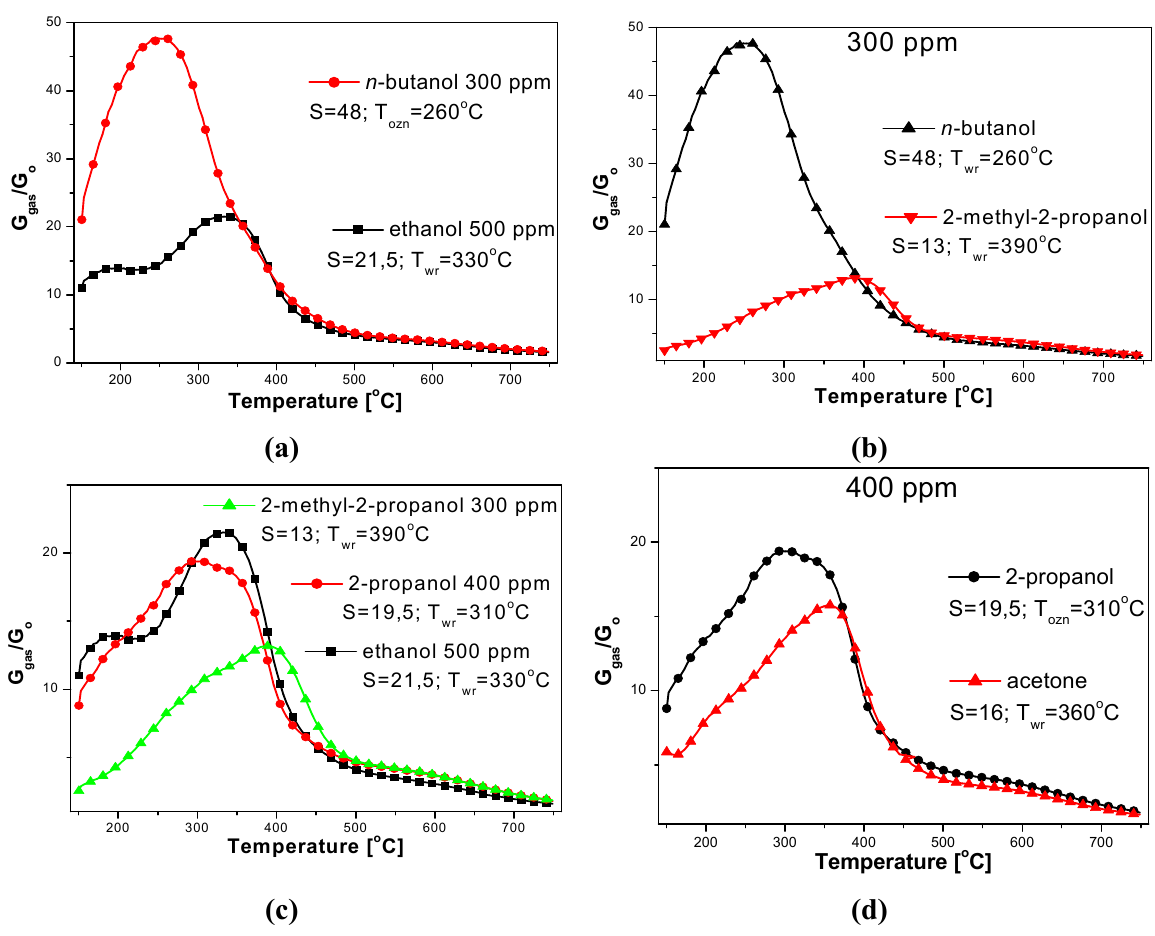
Figure 6. Temperature dependence of sensors sensitivity on (a) the number of carbon atoms in the molecule, (b) the molecule shape, (c) order of alcohol, (d) kind of functional